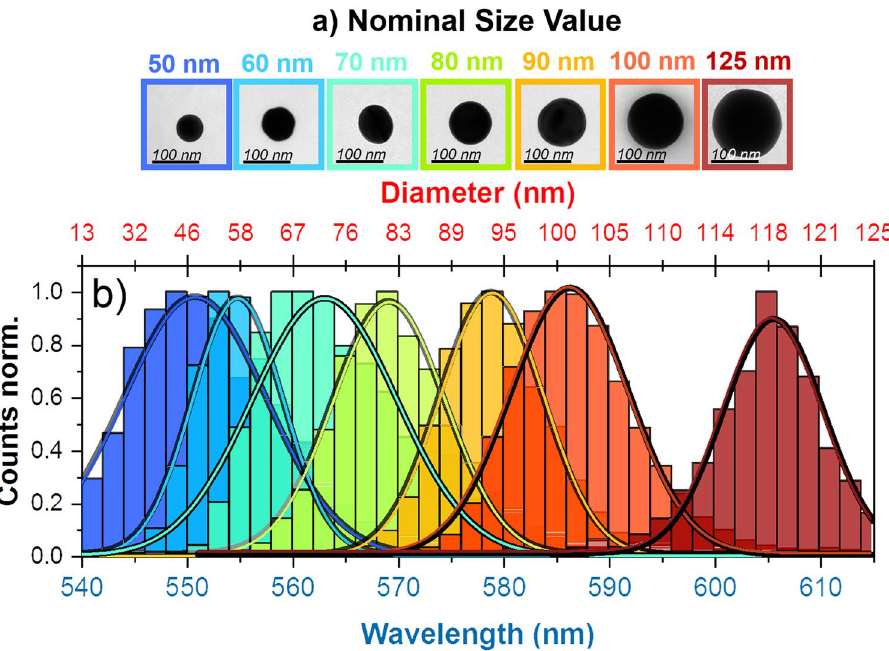
Figure 4. ( a ) TEM images of monomers with different nominal size. ( b ) Histogram distributions of the plasmon resonance peak of all seven nanoparticle lots characterized; the histogram’s top axis has been converted to nanoparticle diameter by making use of Eq. (1). Each histogram has been fitted with a Gaussian distribution (solid line).